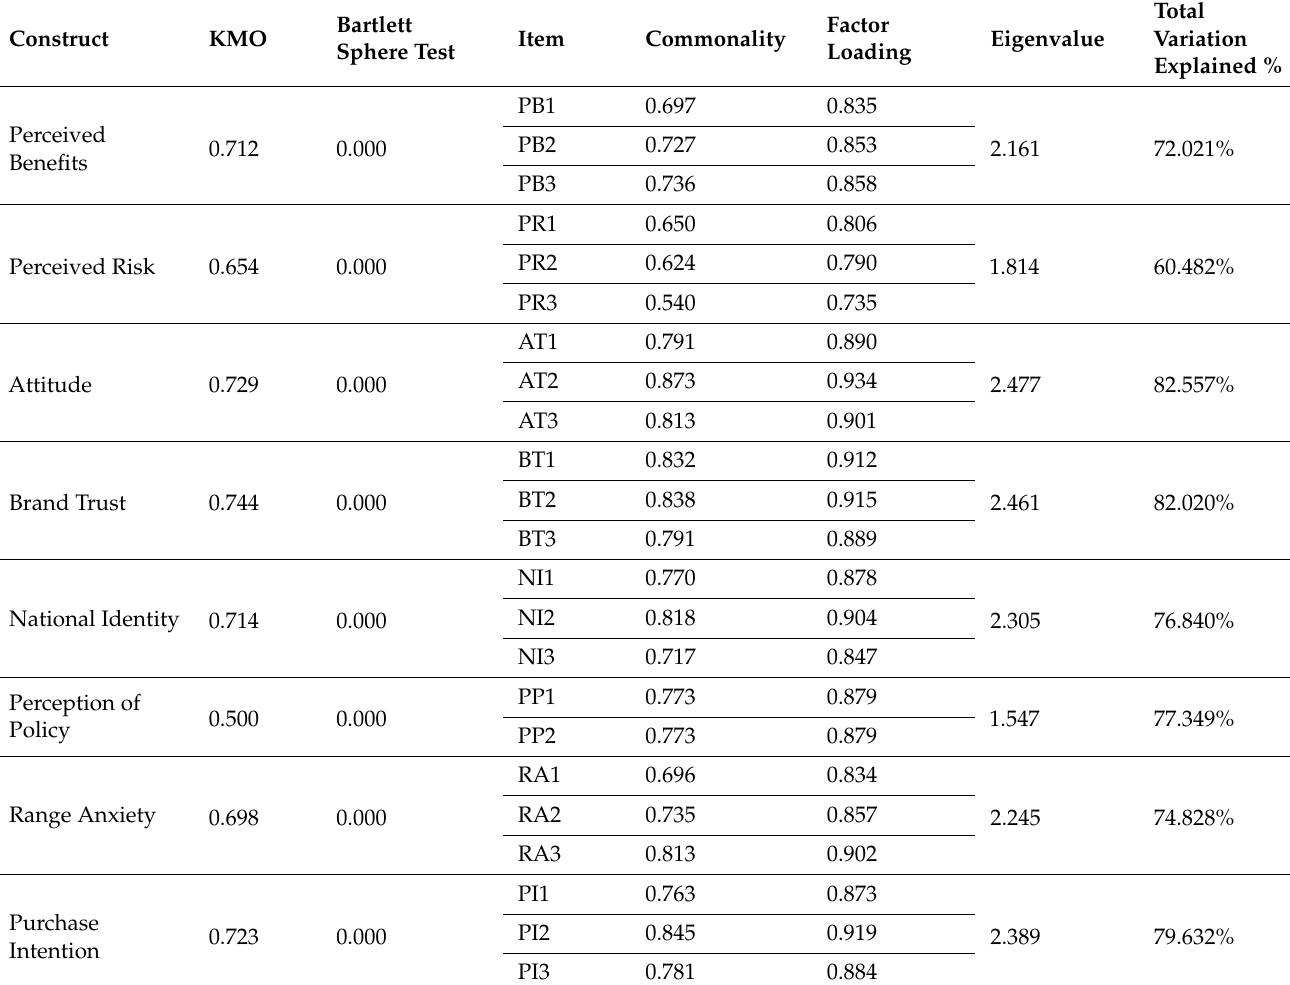
Table 4. Results of exploratory factor